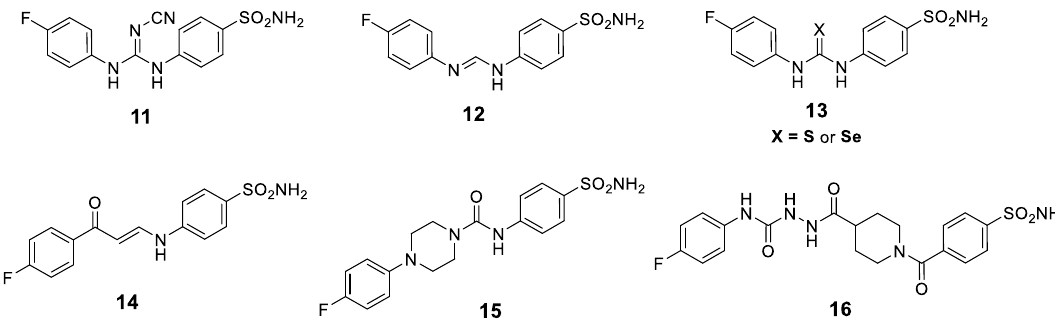
Figure 3. Chemical structures for SLC-0111 analogs ( 11 – 16 ) developed through modification of the SLC-0111 ureido linker.